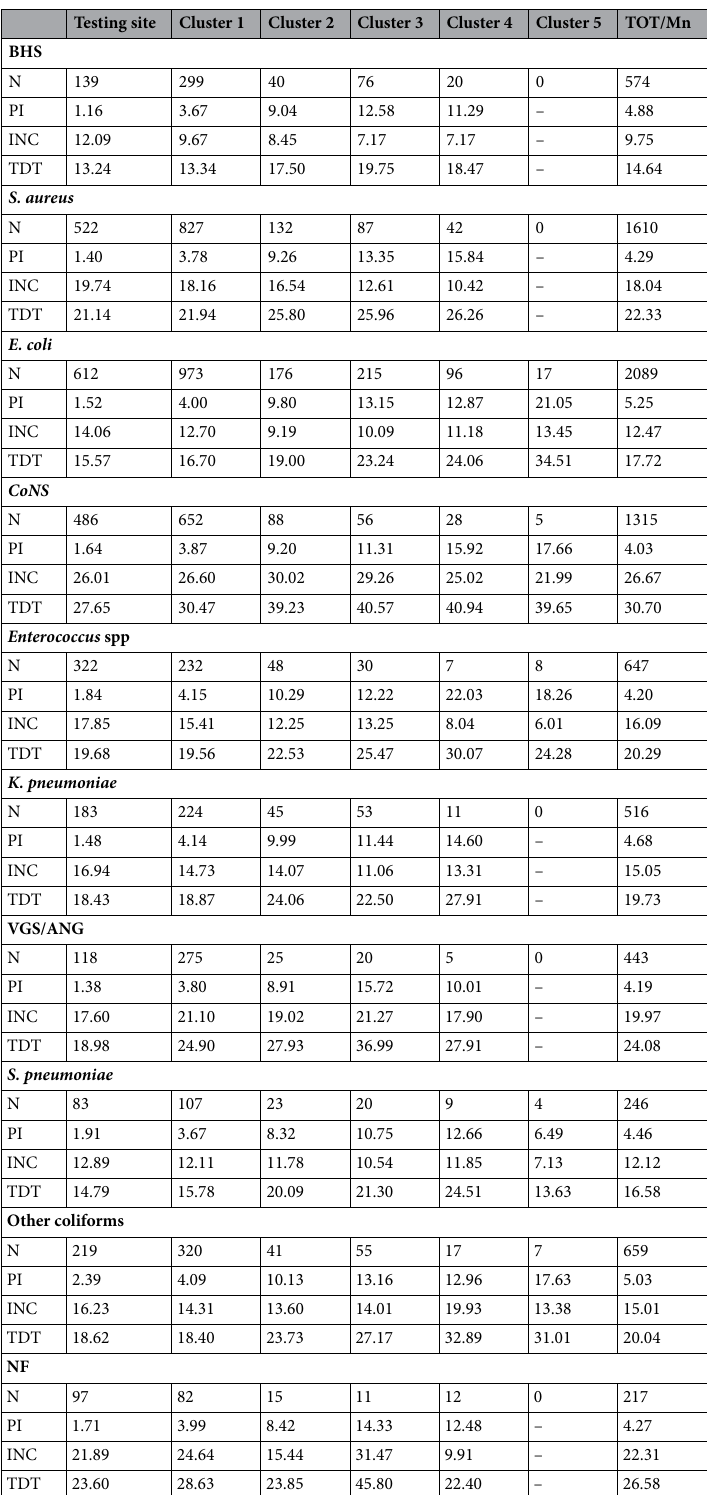
Table 2. Mean INC and TDT (h) for various bacterial species or groups per site clusters. N: number of isolates, PI: preincubation time, BHS: beta-hemolytic Streptococcus , CoNS: coagulase-negative Staphylococcus , VGS/ANG: viridans group Streptococcus and S. anginosus group, Mn: mean, NF: non-fermenting gram negative bacilli, TOT: